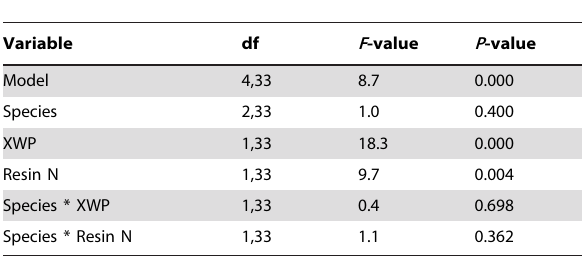
Table 1. GLM of aboveground annual net productivity (ANP), with as independent factor species, and as covariates pre- dawn xylem water potential (XWP) and soil mineral nitrogen (resin